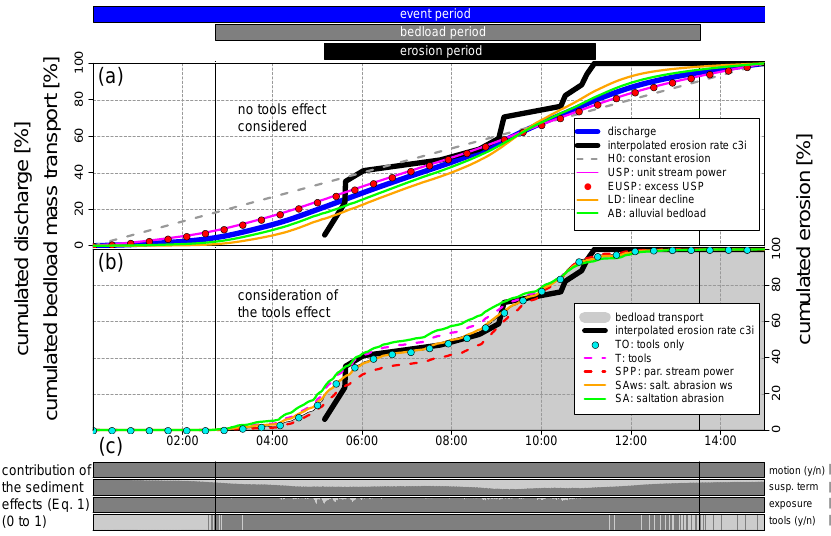
Figure 2. Evolution of the modeled erosion signals over the flood event compared to discharge, bedload mass transport and interpolated erosion rate (see Table 2 and Appendix A for model descriptions) given for the event period. Positions of all three simulation time periods are shown on top like in Fig. 1. (a) Scaled predictions of constant erosion and models neglecting the tools effect (models USP to AB), (b) scaled predictions for models incorporating the tools effect (models TO to SA) and (c) the transient evolution of the four sediment effects (factors in Eq. 1; data resolution is in minutes). Note that the threshold of motion term and the tools term are binary, but the suspension term and the fraction of exposure term can continuously vary between 0 and 1; see text for further